Question: Summarize what this figure shows in one sentence.
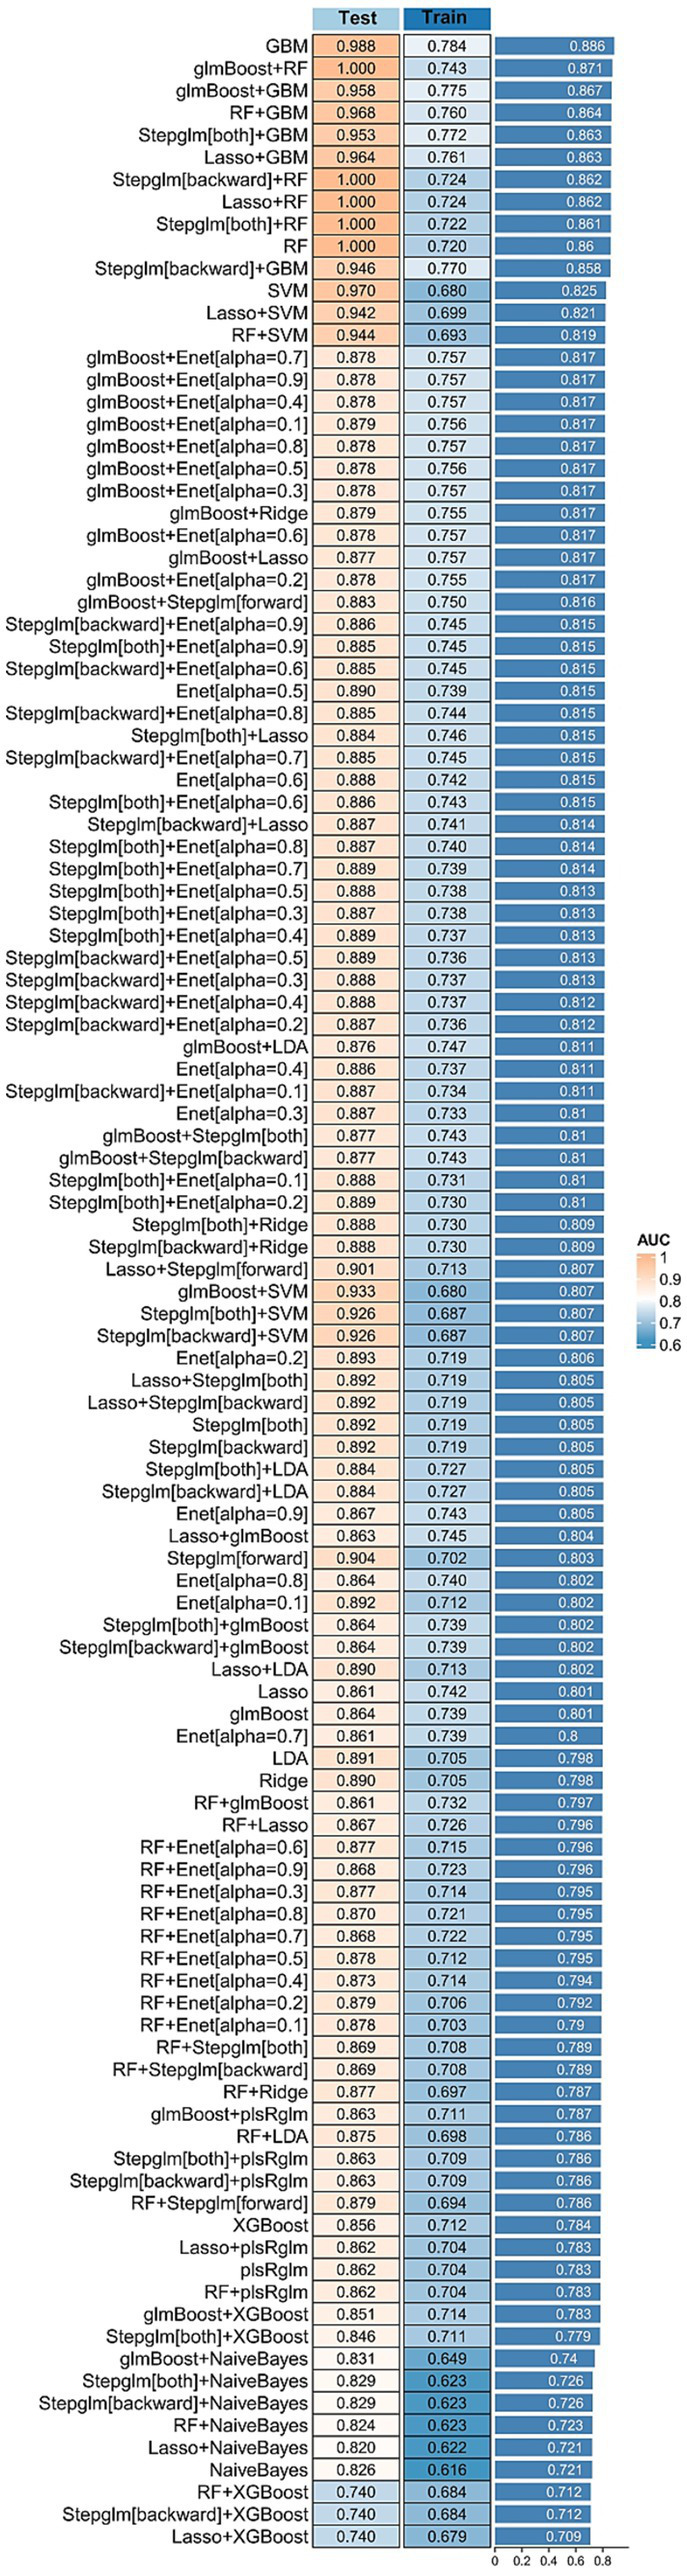
Answer: Performance comparison of different machine learning models in predicting the risk of severe Mycoplasma pneumoniae pneumonia. The horizontal axis represents the area under the curve (AUC). Models are sorted in descending order of AUC values on the test set (orange bars). Blue bars represent AUC values on the training set. The third, rightmost column explicitly displays the mean value of the training and test set AUCs for each corresponding model. GBM, Gradient Boosting Machine; RF, Random Forest; SVM, Support Vector Machine; Enet, Elastic Network; Lasso, Minimum Absolute Shrinkage and Selection Operator; Ridge, Ridge Regression; glmBoost, Generalized Linear Model Boosting; Stepglm, Stepwise Generalized Linear Model; plsRglm, Partial Least Squares Generalized Linear Model; XGBoost, Extreme Gradient Boosting; NaiveBayes, Naive Bayes; LDA, Linear Discriminant Analysis.